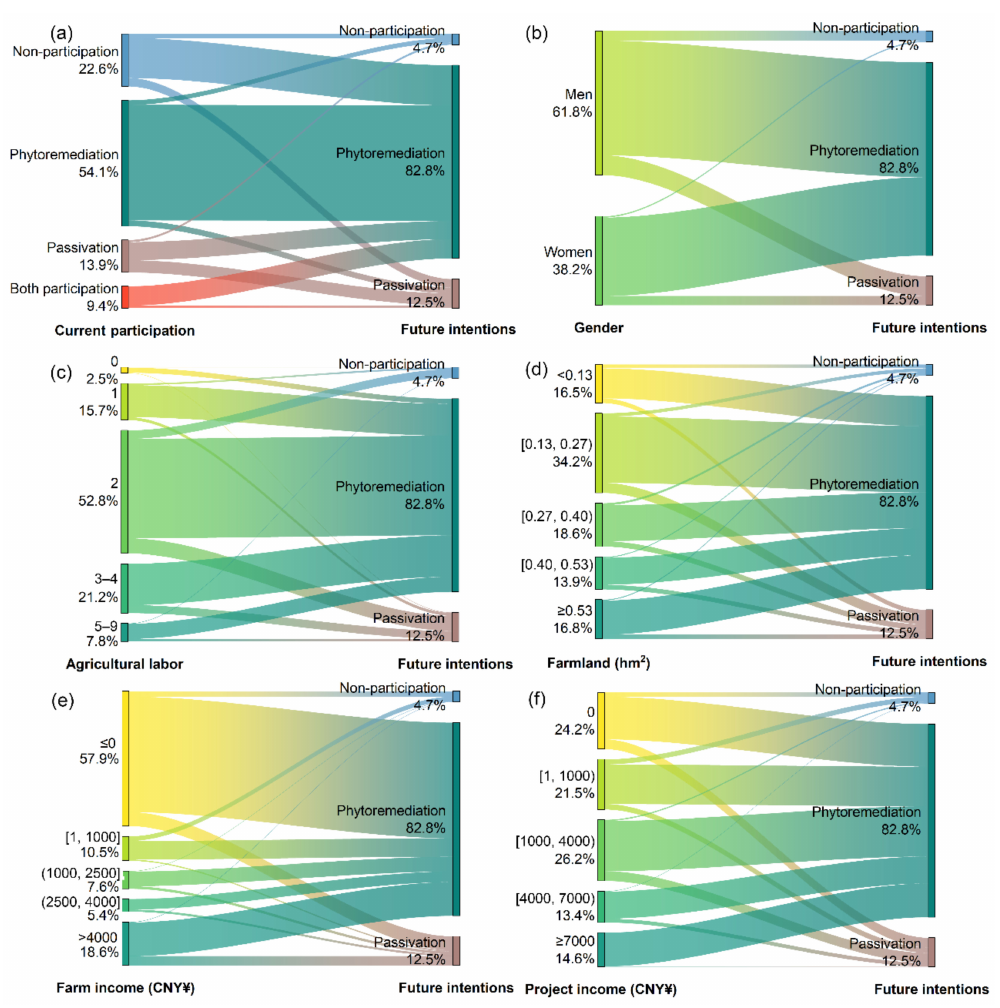
Figure 4. Farmers’ characteristics and remediation intention. Future intentions of farmers with different ( a ) current participation, ( b ) gender, ( c ) agricultural labor, ( d ) farmland, ( e ) farm income, ( f ) project income for soil